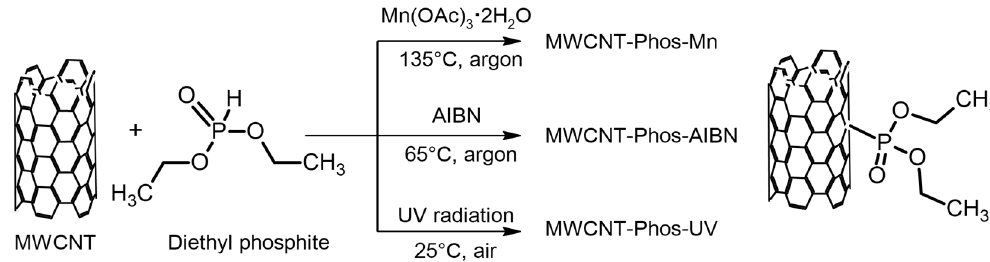
Figure 1. Three pathways leading to phosphonated MWCNTs.